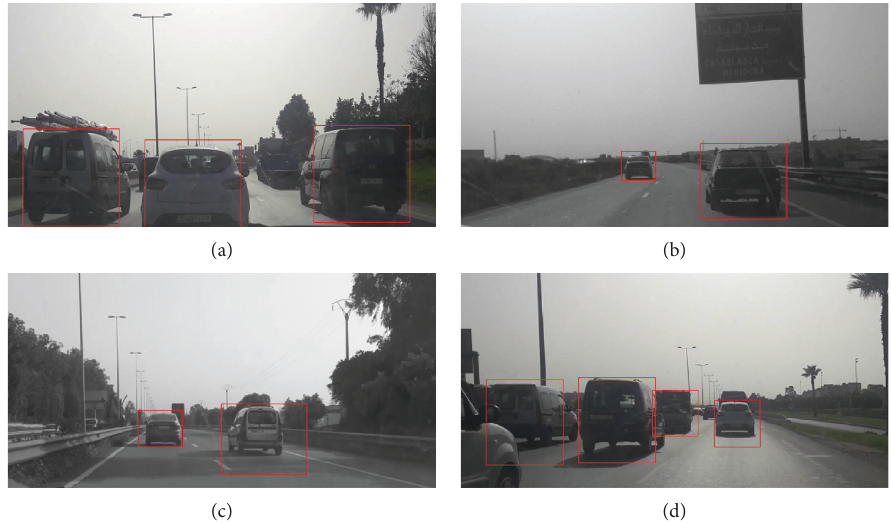
Figure 11: The results of hypothesis verification step of the generated candidates.